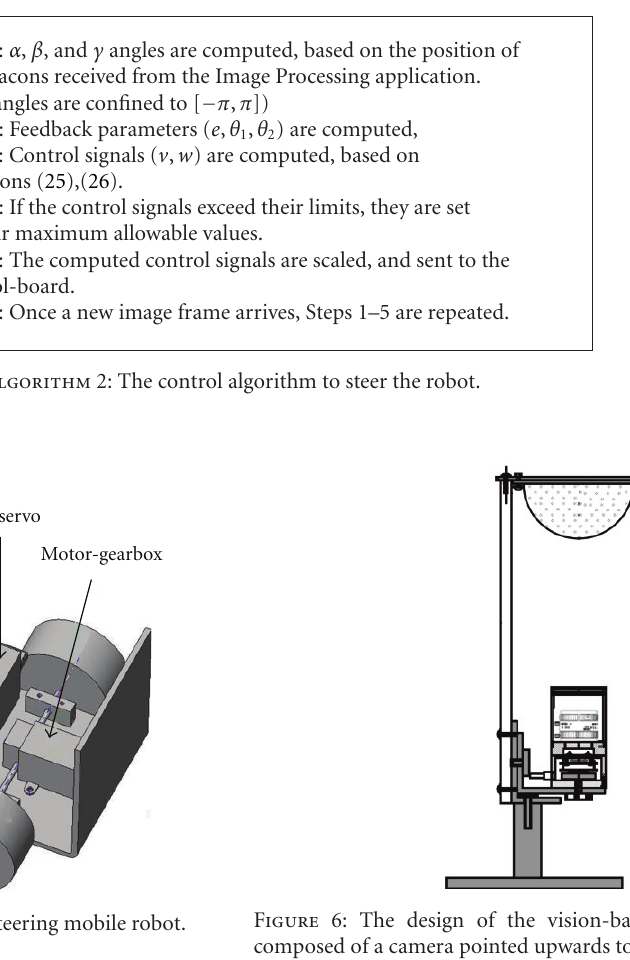
is composed of a camera pointed upwards looking at a spherical mirror, mounted on the top of the robot (Figure 6). We do not assume to know any camera/mirror calibration parameters (mirror size or focal length). Three red, green, and blue color objects are considered as beacons, located on the top of the target rover to determine the pose of the target. The colored-beacons are detected by